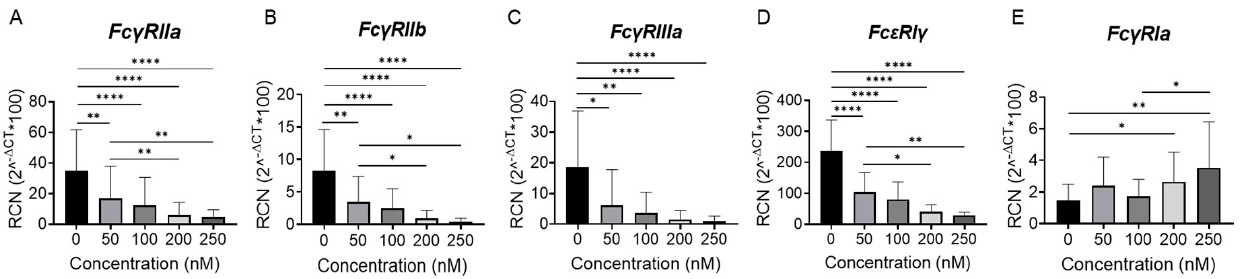
decrease except upon 50 nM PLX51107 treatment (Figure 2D). Inhibition of BET proteins by Figure 1. BET inhibition reduces Fc γ R transcript in human monocytes. Healthy donor CD14+ PLX51107 also caused a modest reduction in surface Fc γ RIIa and Fc γ RIIIa, as measured by monocytes were cultured for 24 h with PLX51107 (50, 100, 200, 250 nM) or with vehicle control flow cytometry. Furthemore, total surface Fc γ R expression was decreased upon PLX51107 (DMSO). Transcript expression was analyzed by real-time PCR for ( A ) Fc γ RIIa, ( B ) Fc γ RIIb, ( C ) Fc γ RIIIa, ( D ) Fc ε RI γ , and ( E ) Fc γ RIa. (n = 8). * p ≤ 0.05, ** p ≤ 0.01, **** p ≤ 0.0001 respectively.